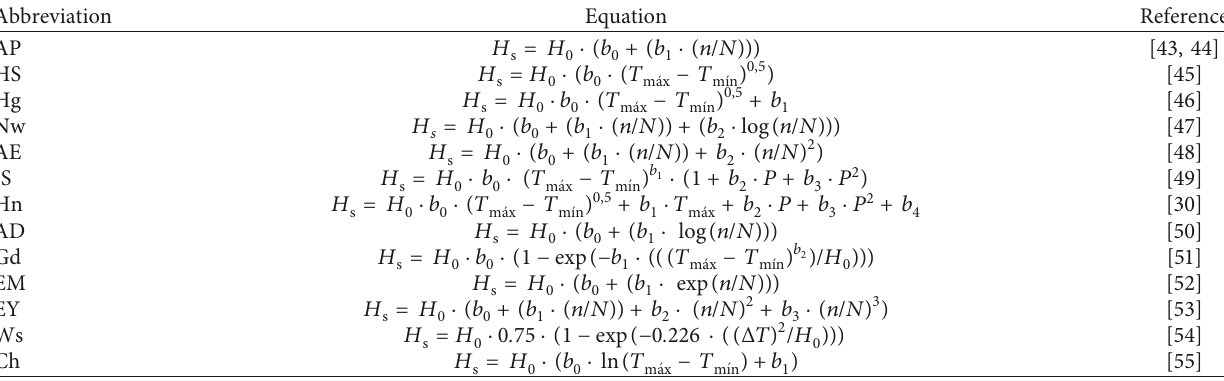
Table 2: Empirical models used to estimate global solar radiation for locations in Minas